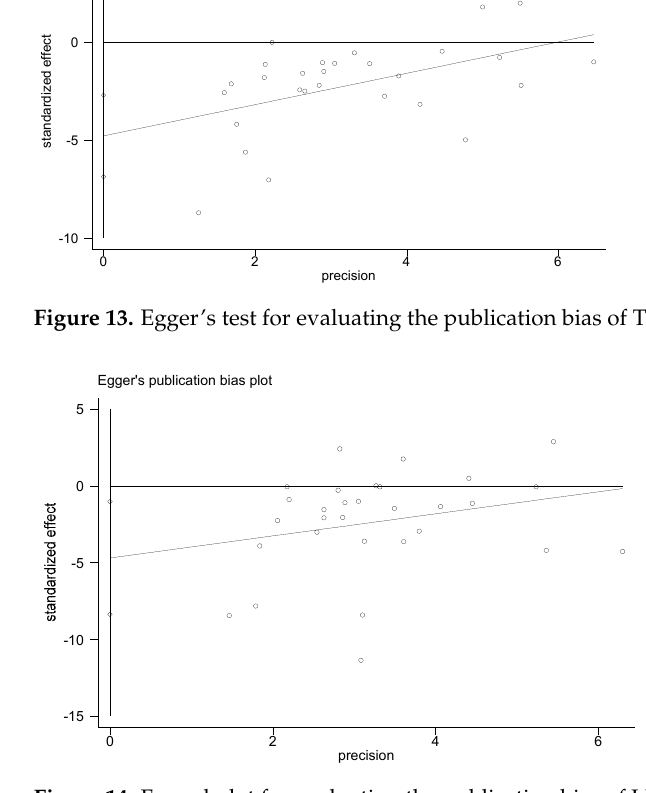
Figure 14. Funnel plot for evaluating the publication bias of LDL − C.